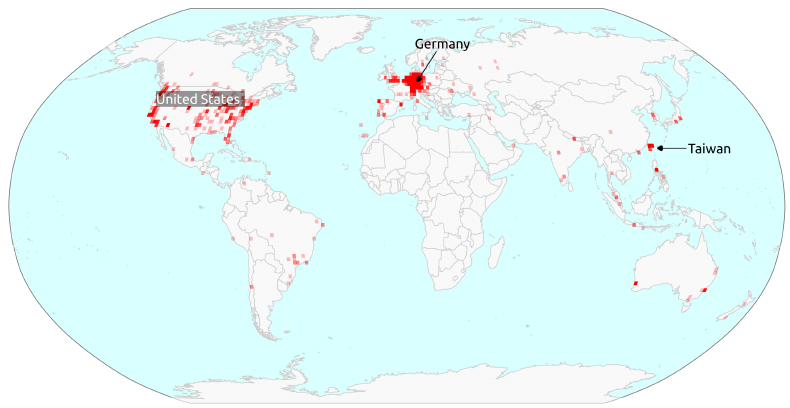
Figure 4. Spatial distribution of PGO vandalism.